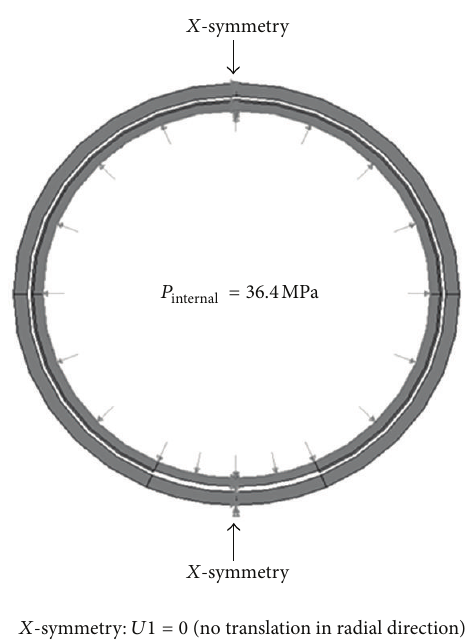
Figure 6: Loading and boundary conditions for the hydroforming model in the first analysis step.